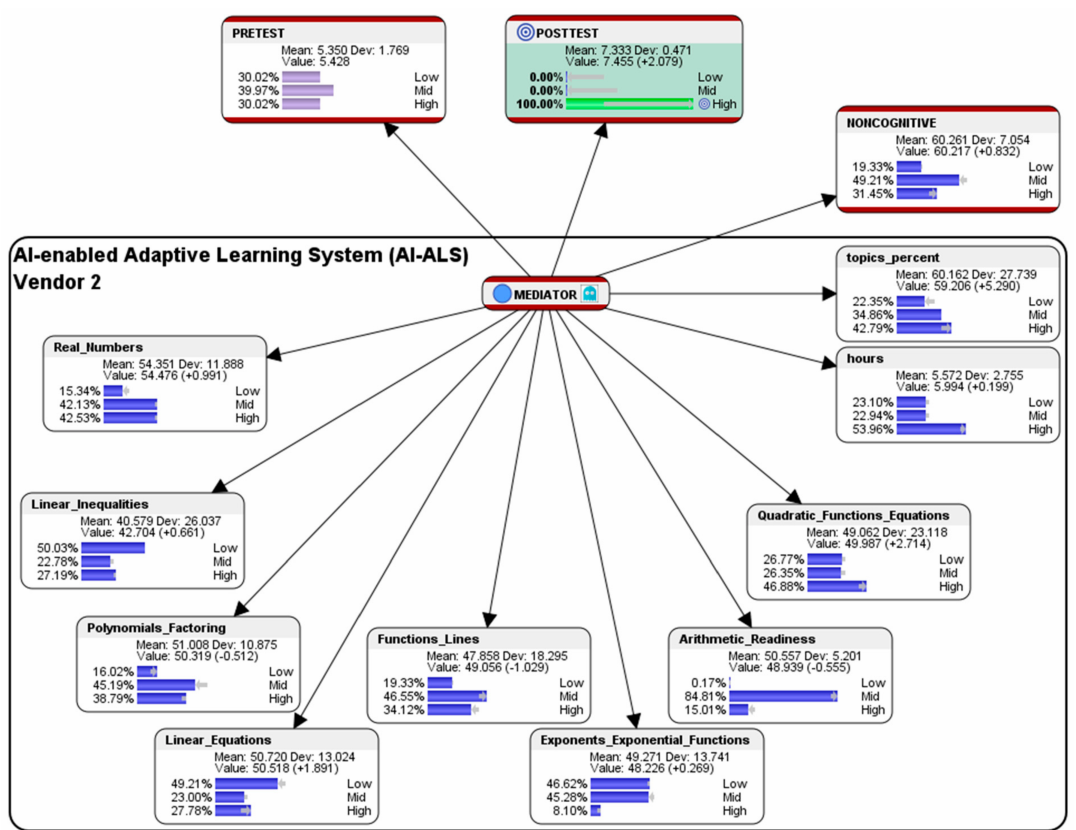
Figure 17. Simulation of counterfactual results for 100% of the students who had used Vendor 2 (cid:48) s AI-ALS to score at the high-level in the